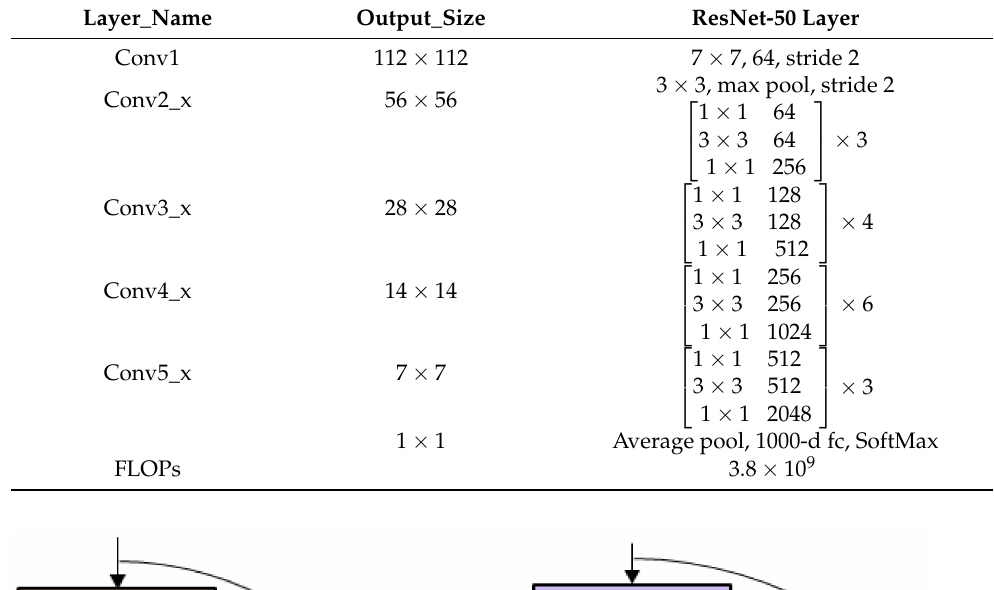
Table 2. ResNet-50 structure in this study.